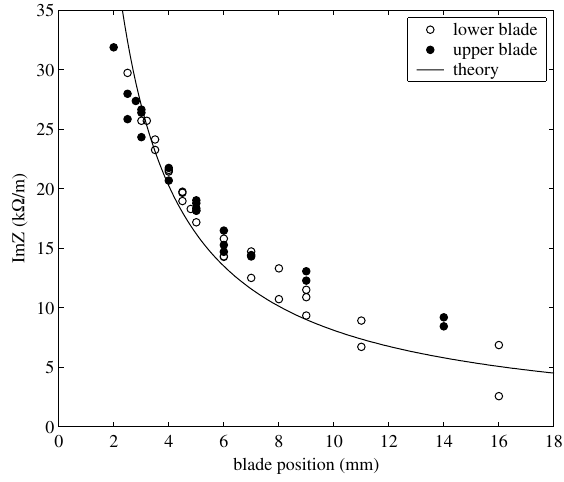
FIG. 12. Scraper vertical impedance.